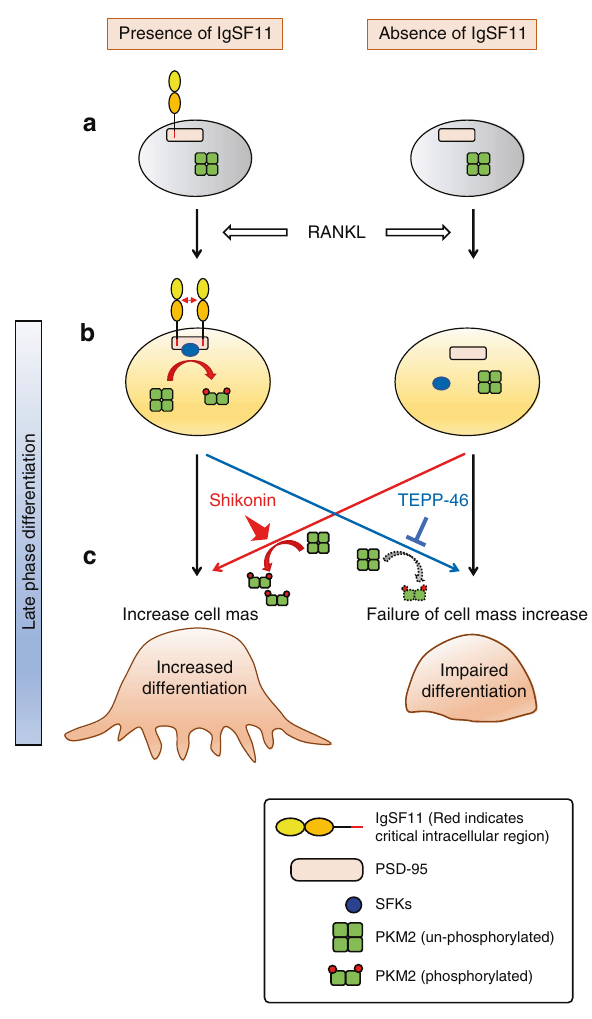
Fig. 7 Schematic depicting the role of IgSF11-mediated regulation of PKM2 activity during osteoclast differentiation. a PKM2 activity is high in BMMs. RANKL stimulation enhances the expression of IgSF11. b IgSF11 mediates the phosphorylation of PKM2 through Src family kinases (c-Src, Fyn, and HcK) in a manner dependent on the C-terminal region. This phosphorylation leads to the inhibition of PKM2 activity. In the absence of IgSF11, the inhibition of PKM2 activity barely occurs, keeping PKM2 activity high. c IgSF11- mediated inhibition of PKM2 activity increases osteoclast differ- entiation. In the absence of IgSF11, osteoclast differentiation is impaired due to a lack of PKM2 inhibition, which can be rescued by the PKM2-speci fi c inhibitor shikonin. Moreover, the PKM2-speci fi c activator TEPP46 inhibits osteoclast differentiation in the presence of